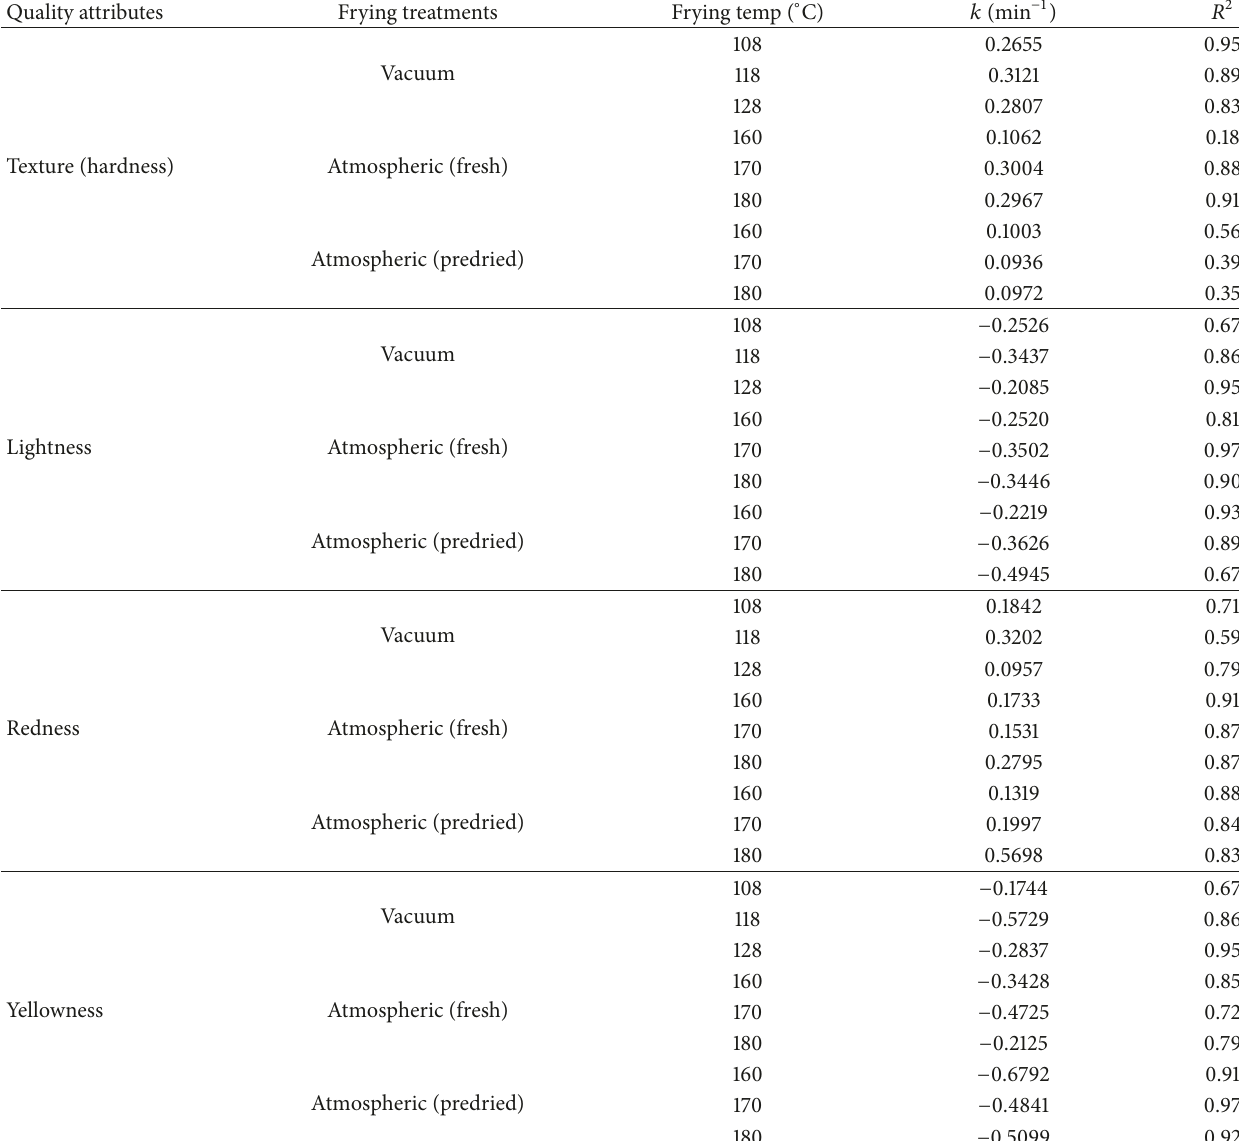
Table 2: Kinetic parameters for quality attributes at different frying